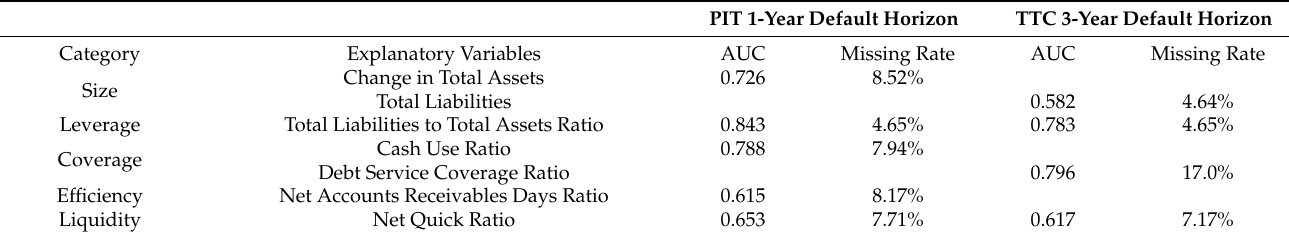
Table 7. Moody’s Large Corporate Financial and Macroeconomic Explanatory Variables Areas Under the Receiver Op- erating Characteristic Curve (AUC) and Missing Rates for 1-Year Default Horizon PIT and 3-Year Default Horizon TTC Default